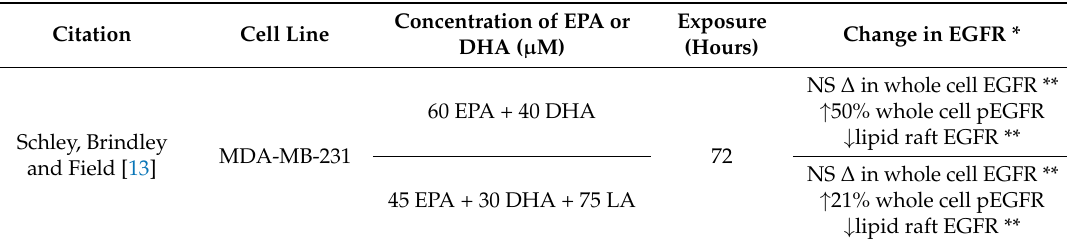
Table 7. Change in total amounts of EGFR and pEGFR in whole cell lipids and lipid rafts with EPA:DHA mixtures in human BC cell